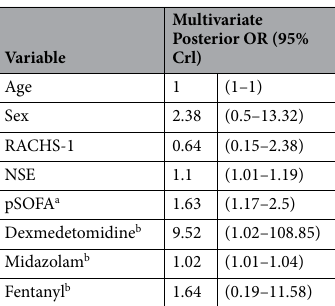
Figure 2. Daily concentrations of NSE. The figure shows the transition of daily concentrations of NSE between groups that experienced delirium during the observation period and those that did not.